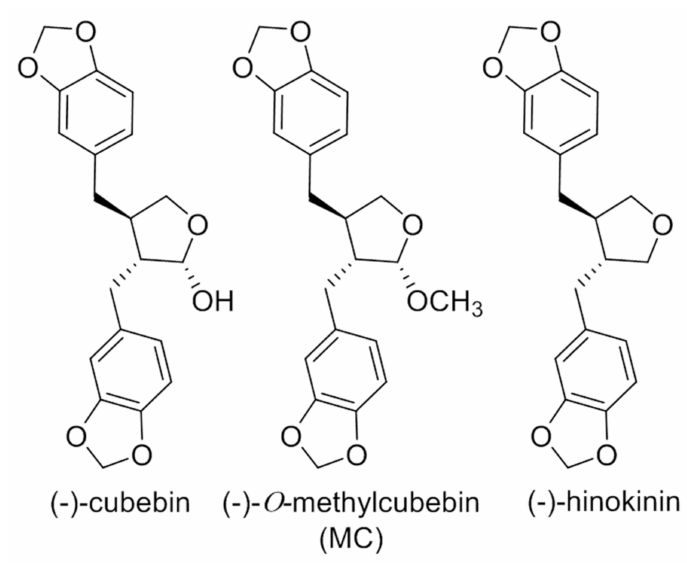
Figure 1. Isolated Compounds.